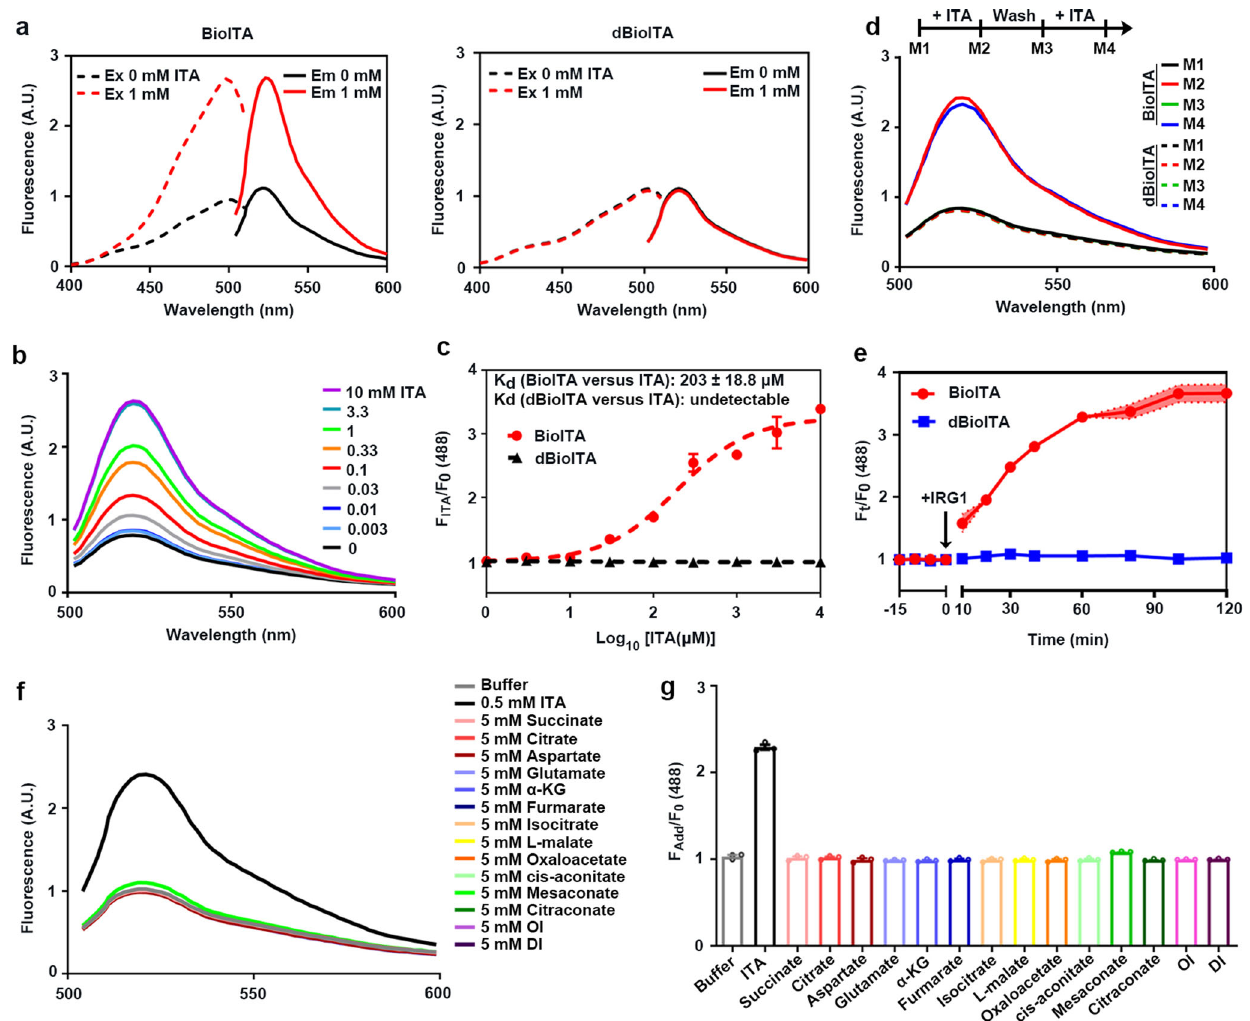
Fig. 2 | Characterizing BioITA sensor. a Fluorescence spectra of puri fi ed BioITA (leftpanel)anddBioITA(rightpanel)inthepresenceof0(black)or1mMitaconate (red). The excitation (Ex, dashed lines) spectrum recorded at an emission wave- length of 530nm has a maximum at 488nm; the emission (Em, solid lines) spec- trum recorded at an excitation wavelength of 488nm has a maximum at 530nm. The experiments were repeated thrice independently with similar results. b Fluorescence emission scans (excitation at 488nm) from BioITA at indicated itaconate concentrations. The scans using buffer serves as a control. The experi- ments were repeated thrice independently with similar results. c Maxima values fromemissionpeaks(excitationat488nm)ofBioITAanddBioITAversusindicated itaconate concentrations were plotted after normalization to F0 (without itaco- nate). The itaconate dissociation constant (Kd) of BioITA was determined as 203±18.8 μ M. The data indicated at different itaconate concentrations are shown as mean±SD of three independent experiments. d Flowchart of fl uorescence